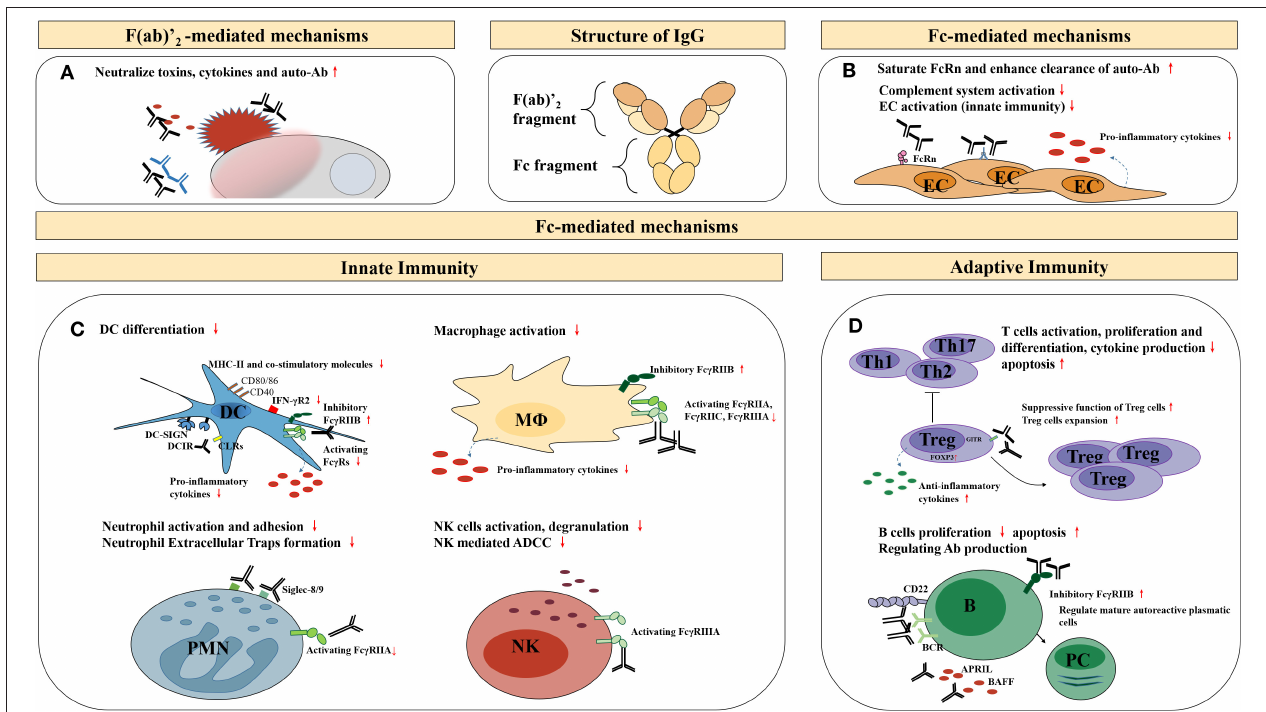
FIGURE 1 | Potential anti-inflammatory, immunomodulatory mechanisms of high-dose IVIg therapy. EC, endothelial cells; DC, dendritic cells; M Φ , macrophages; PMN, granular leukocyte; NK, natural killer cells; ADCC, antibody-dependent cell-mediated cytotoxicity; B, B cells; PC, plasma cells; BCR, B-cell receptors; APRIL, a proliferation-inducing ligand; BAFF, B-cell activating factor of the TNF family. (A) Neutralization of pathogenic antigens through the F(ab) ′ 2-mediated mechanisms; (B) The immunomodulatory effects on endothelial cells through the Fc-mediated mechanisms; (C) The immunomodulatory effects on other innate immune cells through the Fc-mediated mechanisms; (D) The immunomodulatory effects on adaptive immune cells through the Fc-mediated